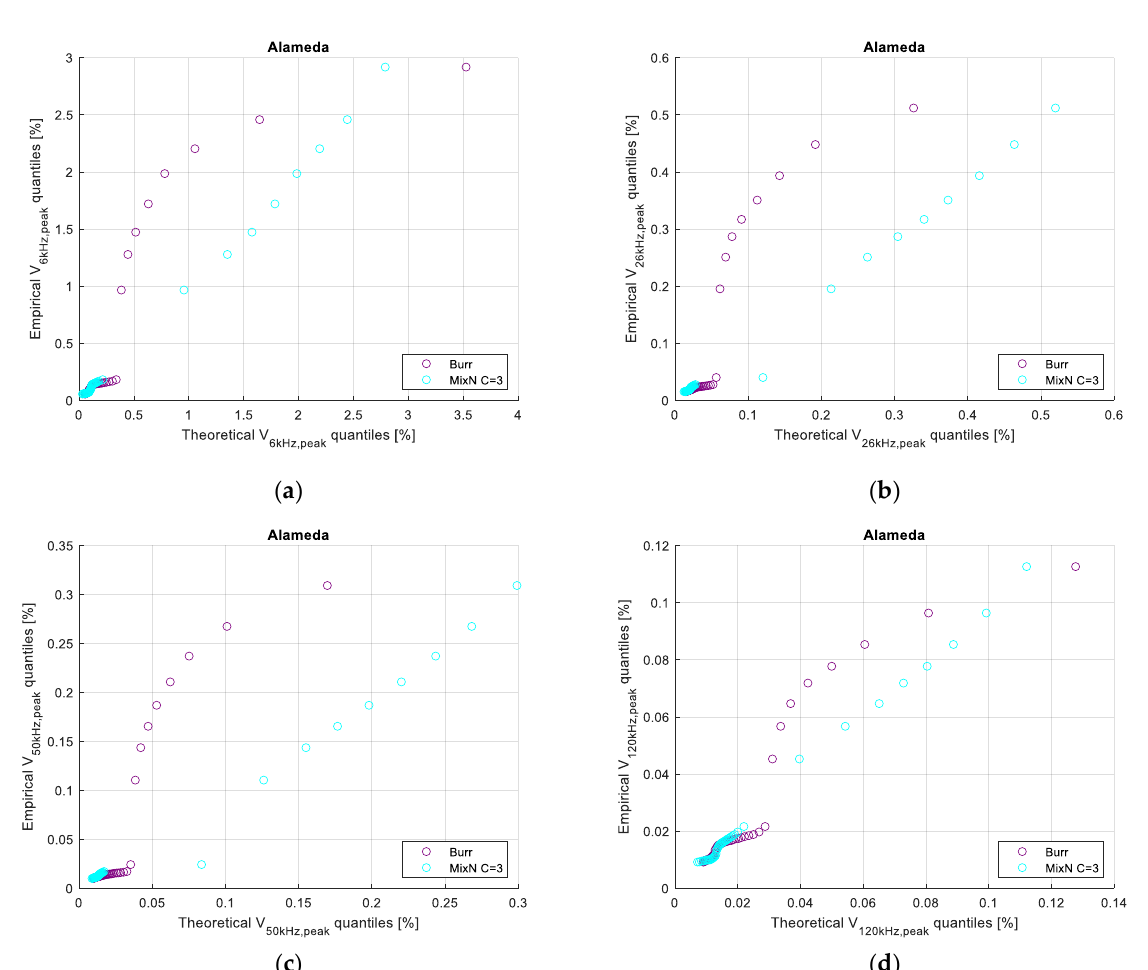
Figure 5. Q-Q plots of the: ( a ) 6-kHz; ( b ) 26-kHz; ( c ) 50-kHz; ( d ) 120-kHz peak voltage component at Alameda (CA).